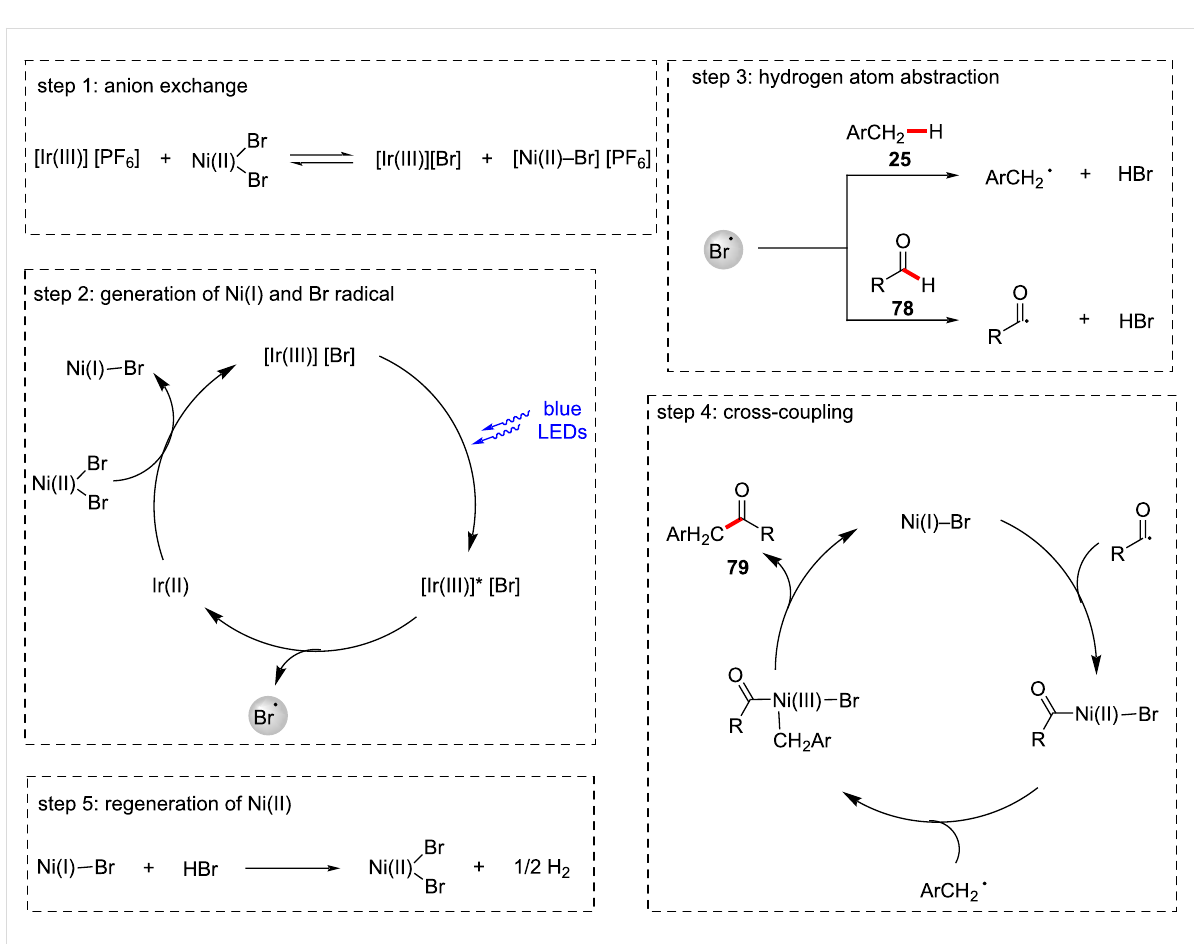
Figure 18: Proposed reaction pathway for the photoredox nickel-catalyzed dehydrogenative coupling of benzylic and aldehydic C–H